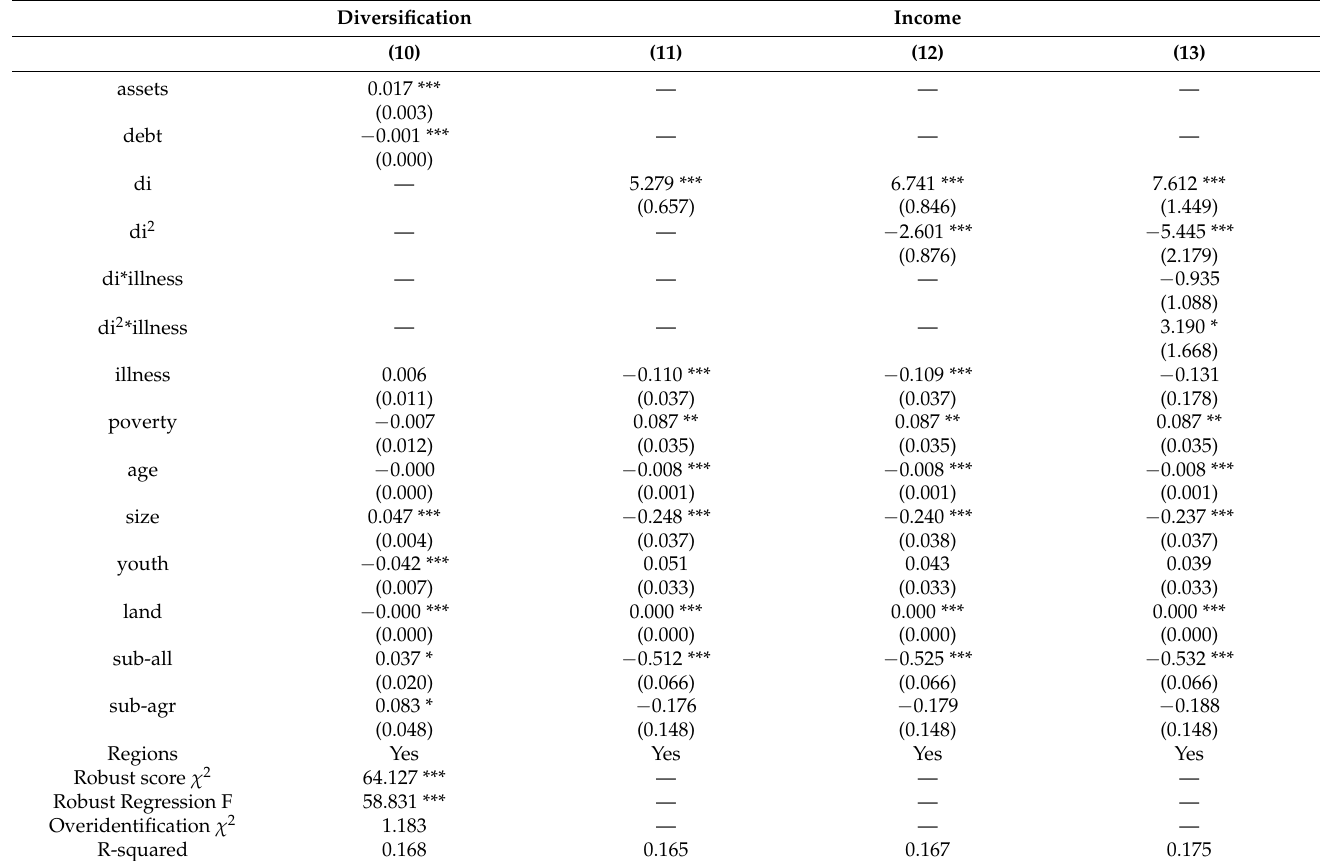
Table 4. Diversification and income enhancement by